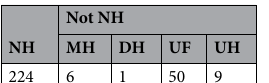
Table 1. Hatching status of the collected 290 eggs.